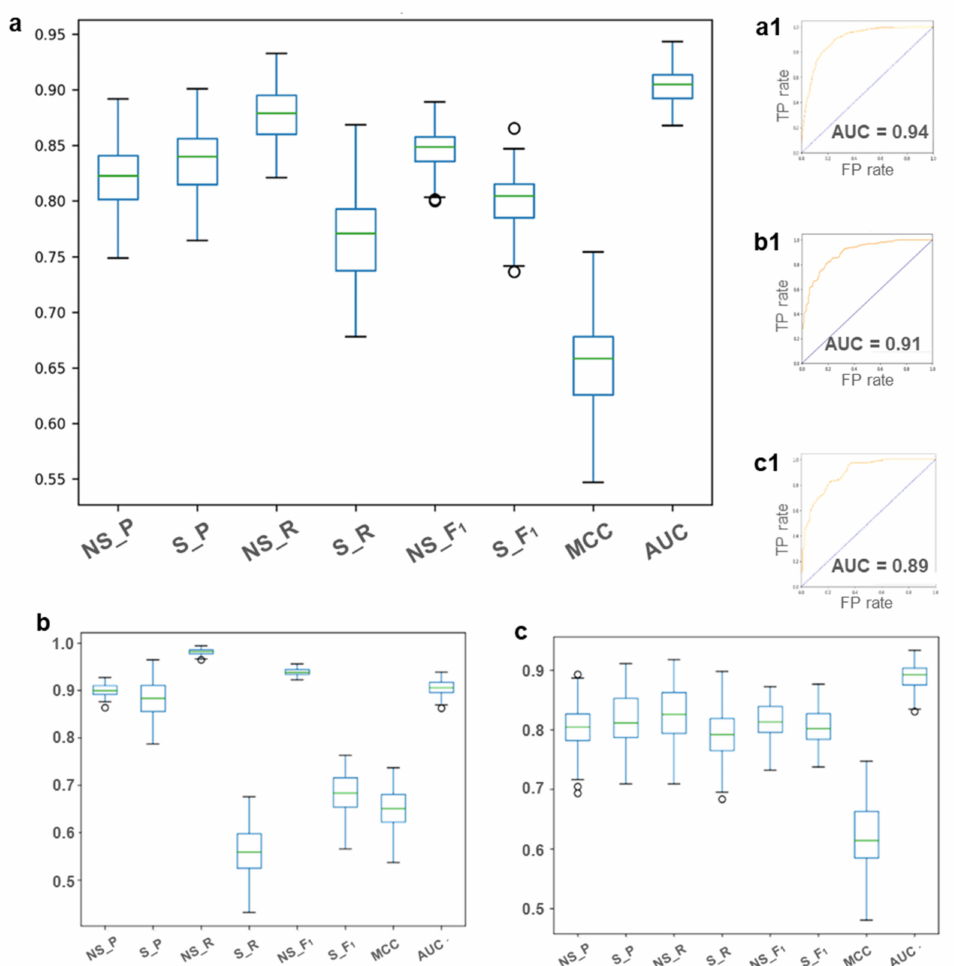
Figure 2. Box plots of the three MCCV models ( a ): MT-dataset, ( b ): MQ-dataset and ( c ): MQ-dataset after the random US, P: Precision, R: Recall, F 1 : F 1 score, MCC: Matthew Correlation Coefficient) and the corresponding ROC curves ( a1 ): MT-dataset, ( b1 ): MQ-dataset and ( c1 ): MQ-dataset after